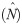
Comparison of abundance estimates (N^) of Derby elands in the Fathala reserve gained from spatially explicit capture-recapture (Null and h2 models) and closed CR models (M0, Mh, Mh Chao) at 66 trapping occasions in a) the grid, b) reduced grid, c) line and, d) reduced line camera trap placement. Whiskers denote standard errors.